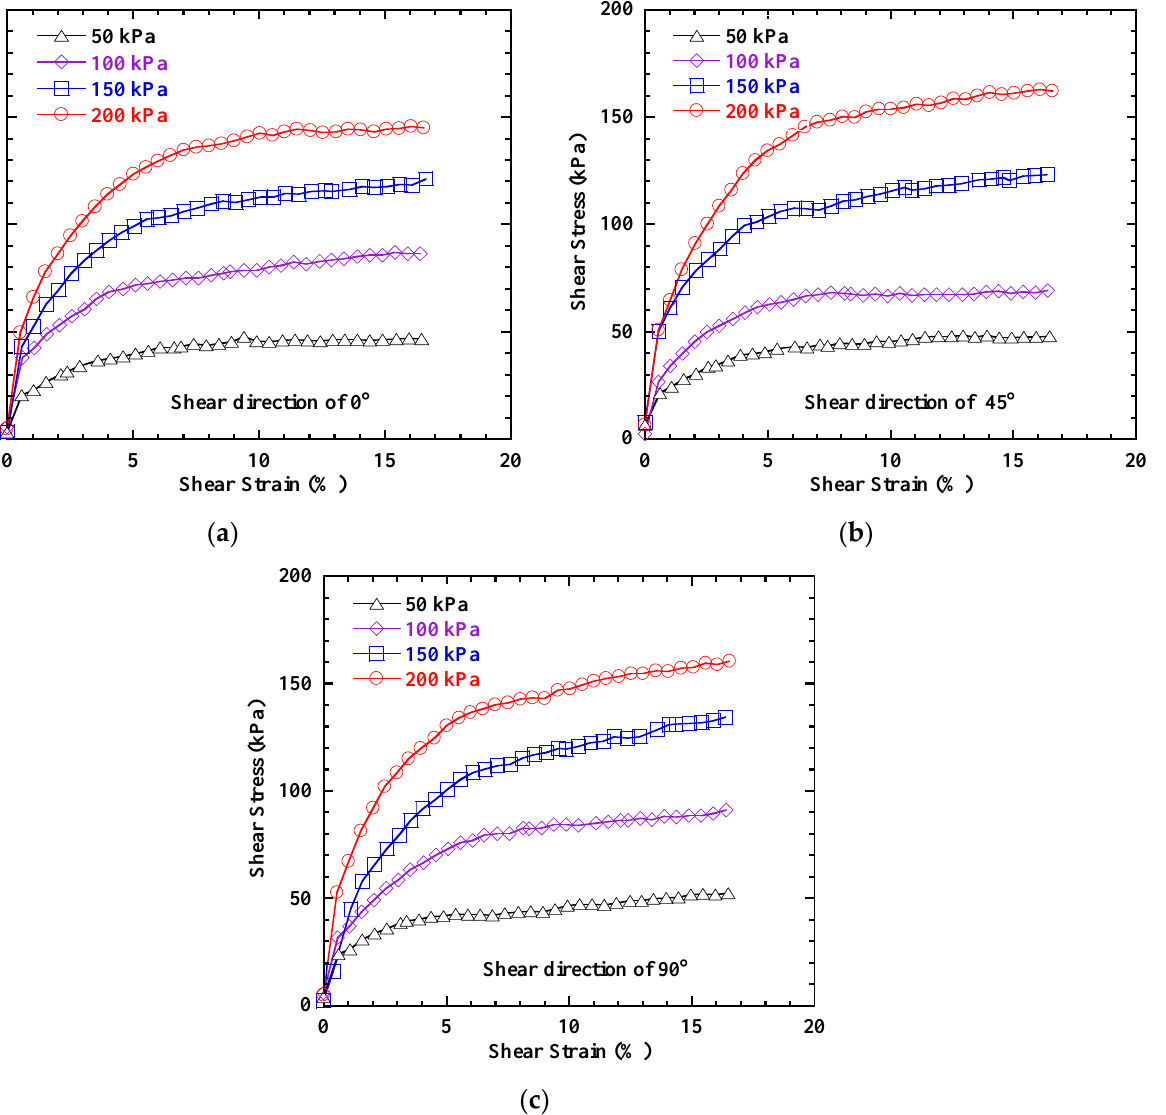
Figure 4. Shear stress–strain curves for fine sand–biaxial geogrid (SS30) interfaces. ( a ) Shear direction of 0°, ( b ) shear direction of 45°, ( c ) shear direction of 90°.